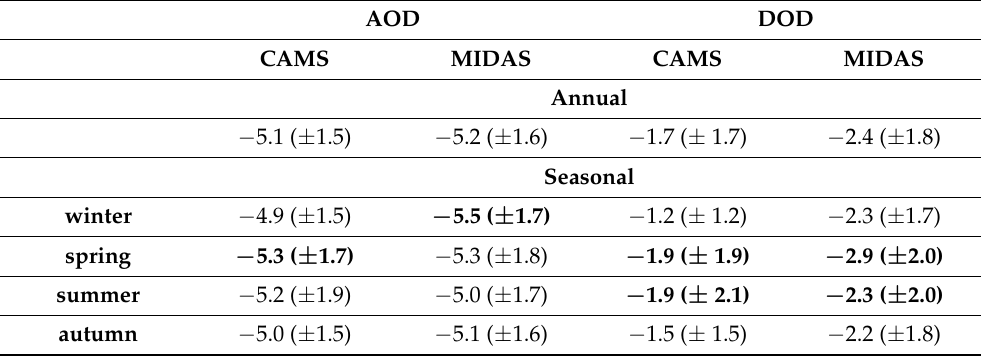
Figure 6. Change (in %) of the mean annual integral of GHI due to the presence of aerosols under ( a ) MIDAS AOD and ( b ) CAMS AOD. Blank grid points are those that did not fulfill the criterion of at least 20% data availability on annual basis. Table 5. Change (in %) of the regional averaged mean annual and seasonal integrals of GHI due to total aerosols (AOD) and dust (DOD) from both datasets of MIDAS and CAMS. The maximum of seasonal values is denoted as bold, emphasizing the peak of the seasonal cycle.